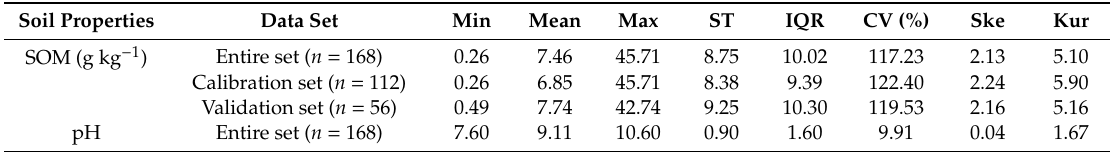
Table 1. Descriptive statistics of soil properties in the study areas.